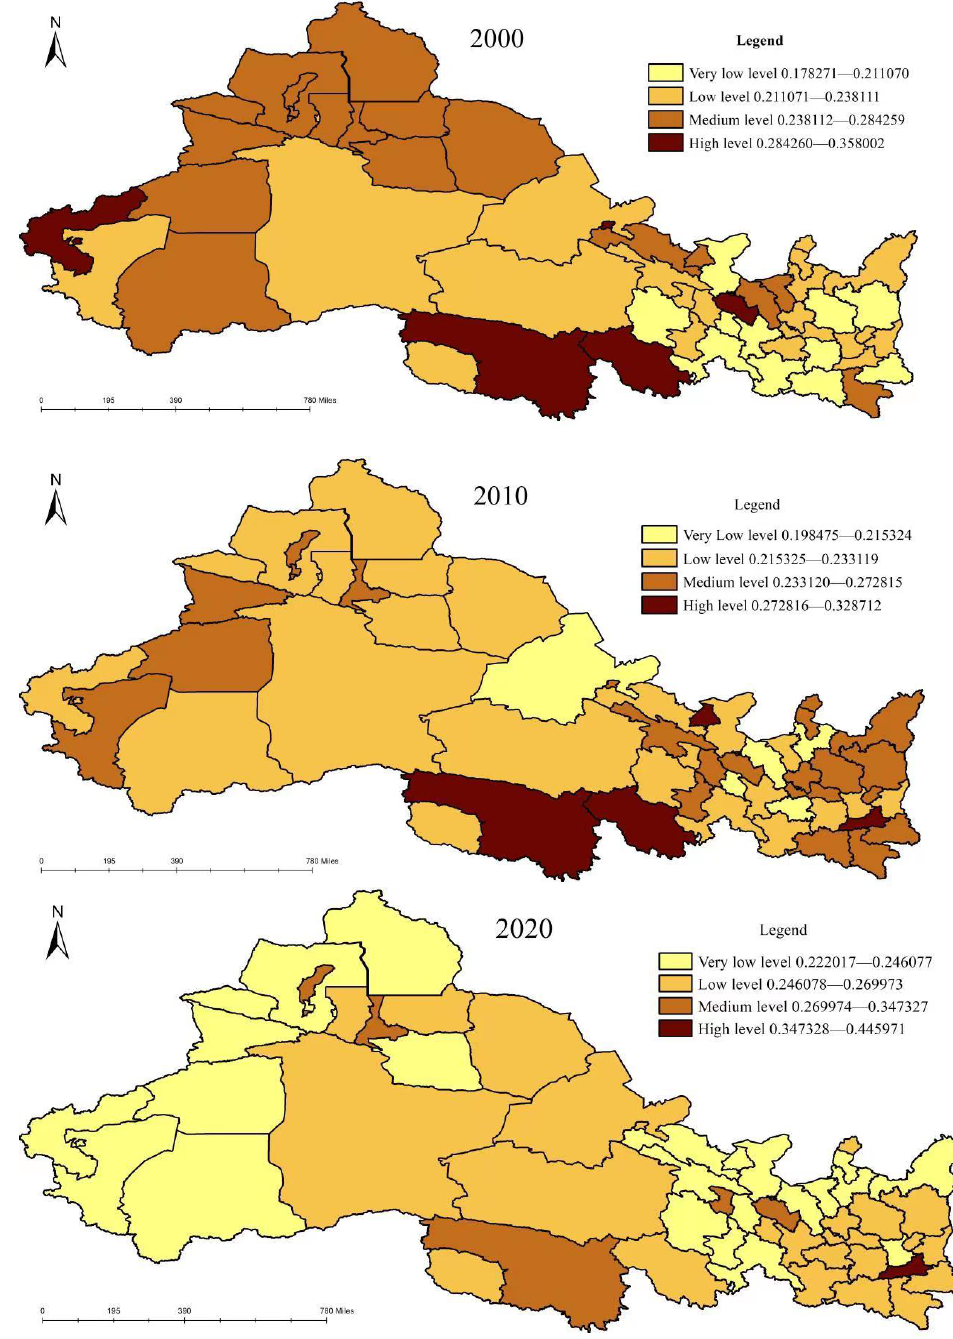
Figure 2. Urban water poverty level in northwest China from 2000 to 2020.